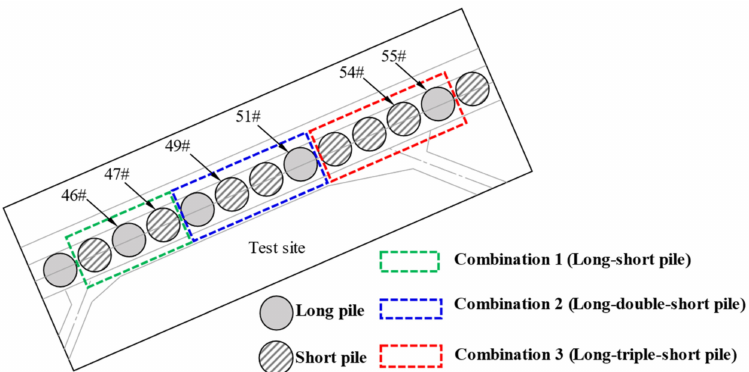
Figure 3. Schematic diagram of working condition layout in the field test site.